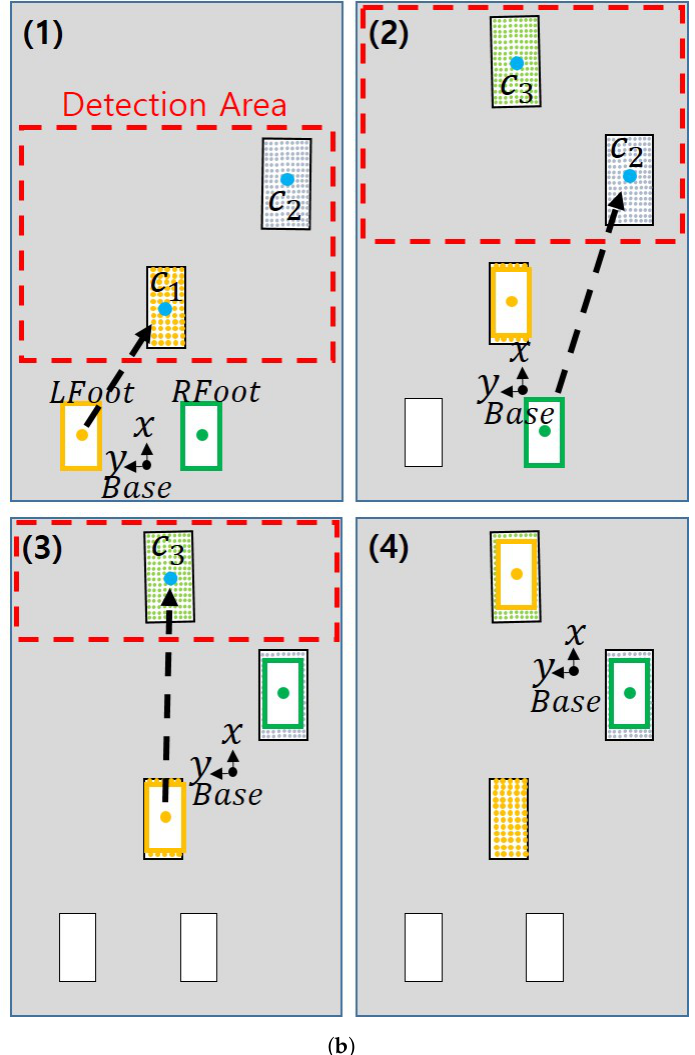
Figure 7. When the first step swing foot is the left foot, the result of reaching the goal. ( a ) ( 1 , 2 ) mean the situation in which each footstep moves. ( b ) ( 1 – 4 ) mean the situation in which each footstep